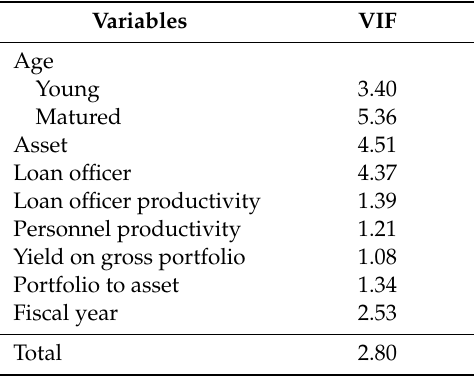
Table A4. Multicollinearity test: Variance inflation factor